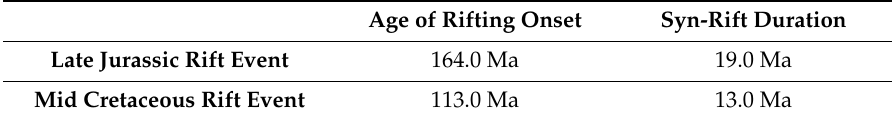
Table 2. Rifting timetable for the West Orphan Basin used for 2D Thermal Subsidence module calculations. For the Rockall Basin, only the Mid Cretaceous rift event was used to calculate the thermal subsidence, due to the fact that no Jurassic sedimentary rocks could be interpreted within the basin due to the quality of the deep seismic data. Parameters from [14,29].